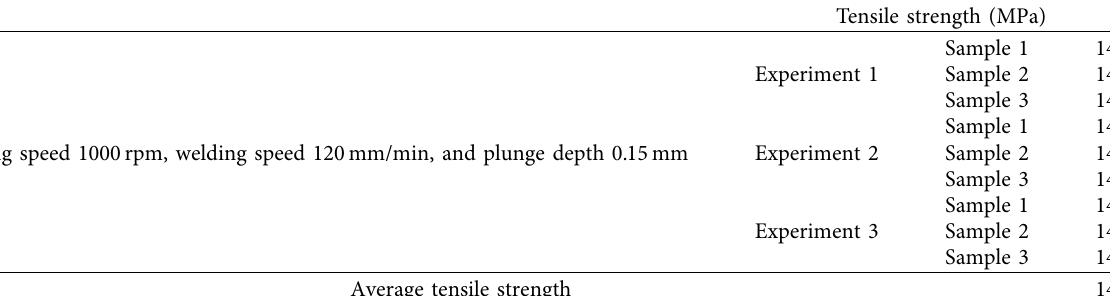
Table 3: FSW process parameters.